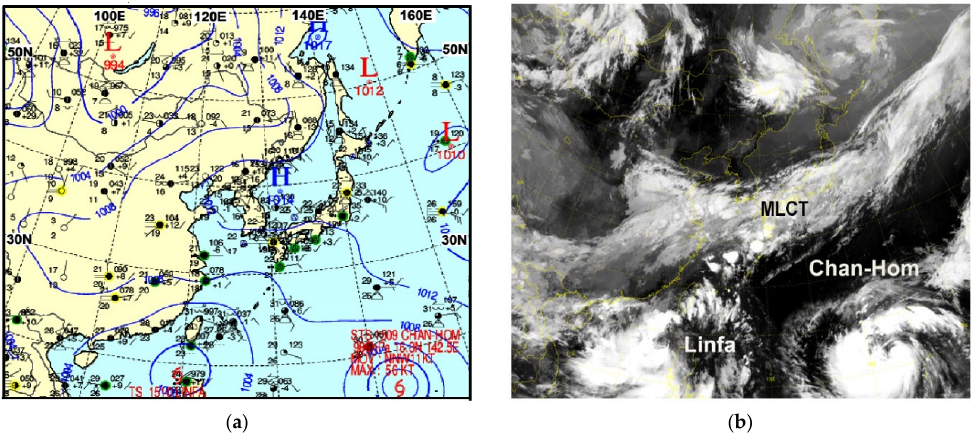
Figure 9. As shown in Figure 3, except for ( a ) surface pressure analysis (hPa) and ( b ) COMS ‐ IR. satellite image at 09:00 LST, 6 July 2015. The multiple interactions between STS Linfa and TY Chan ‐ Hom and between the MLTTC and TY Chan ‐ Hom decreased the distance between them.